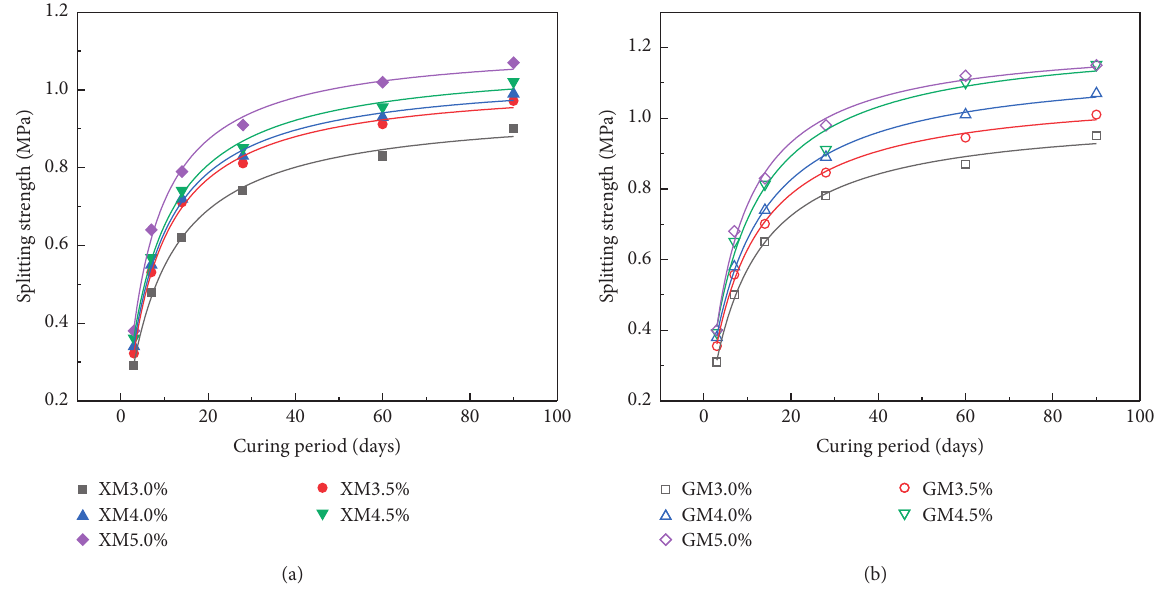
Figure 8: Effect of curing period on splitting strength. (a) GM gradation; (b) XM gradation.